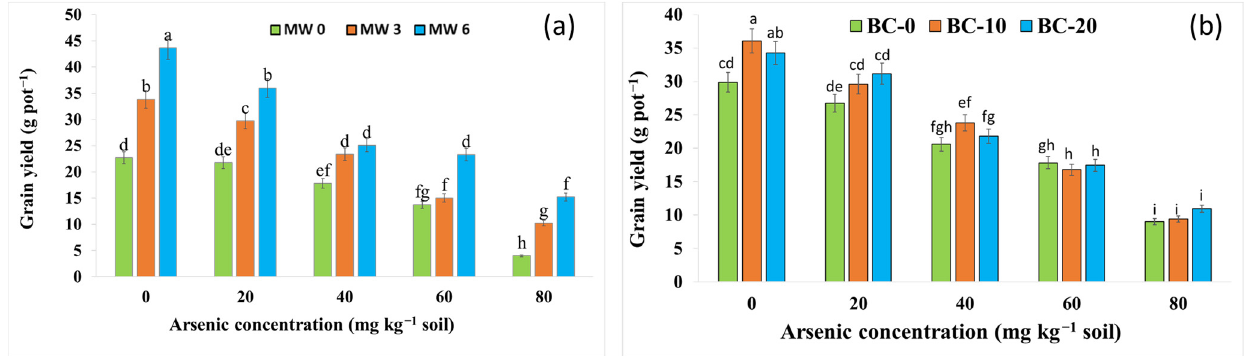
Figure 5. Effect of ( a ) microwave (MW) and ( b ) biochar (BC) treatments on rice grain yield at different soil arsenic (As) concentration. Replicated mean values are shown in bars with standard error. The different letter indicates the significant difference (LSD test at 5% level of significance) among the treatments.